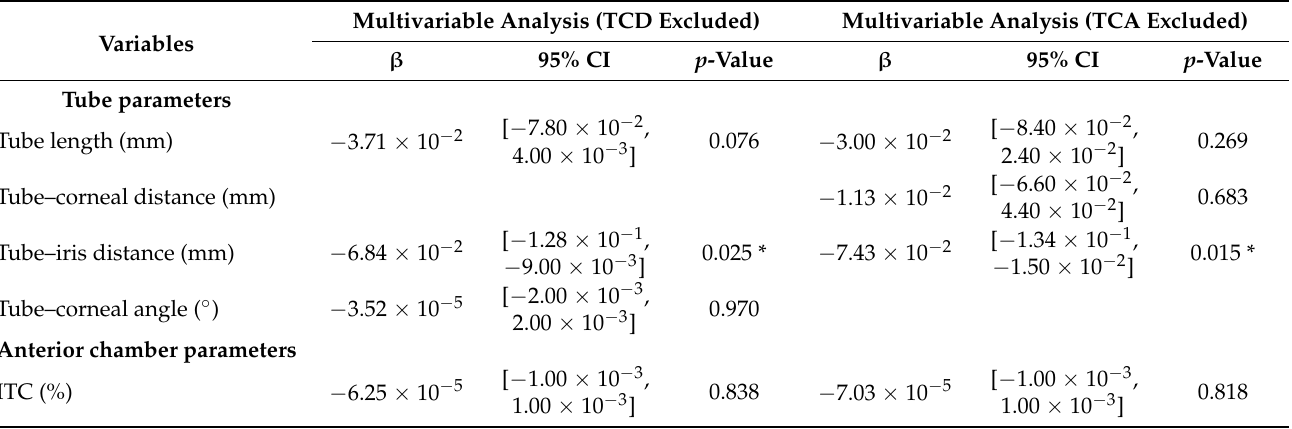
Table 4. Multivariable linear regressions regarding associations with endothelial cell density change rates. Due to the high collinearity between TCD and TCA, one or the other of these variables was excluded when conducting multivariable